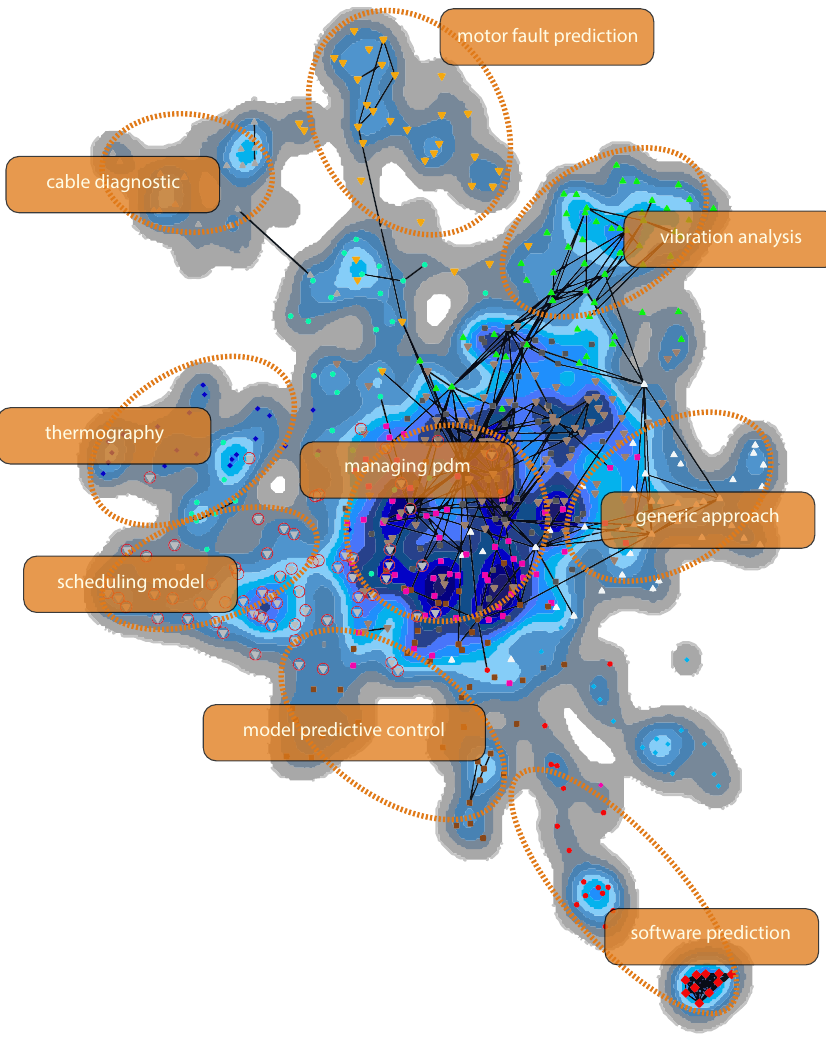
Figure 10. Research Front